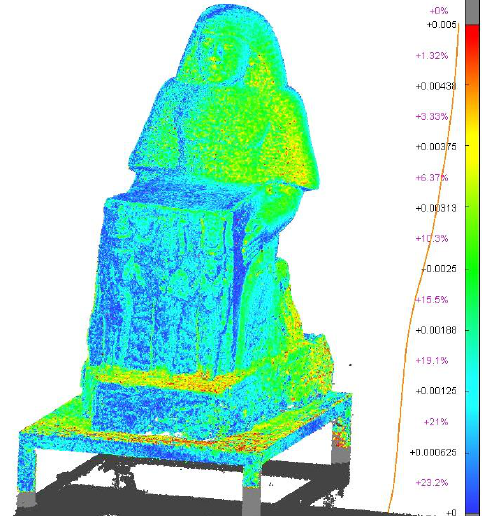
Figure 7. Comparison between clouds: about 60% of the freestyle point clouds are at a distance of less than 2 mm from the reference cloud.